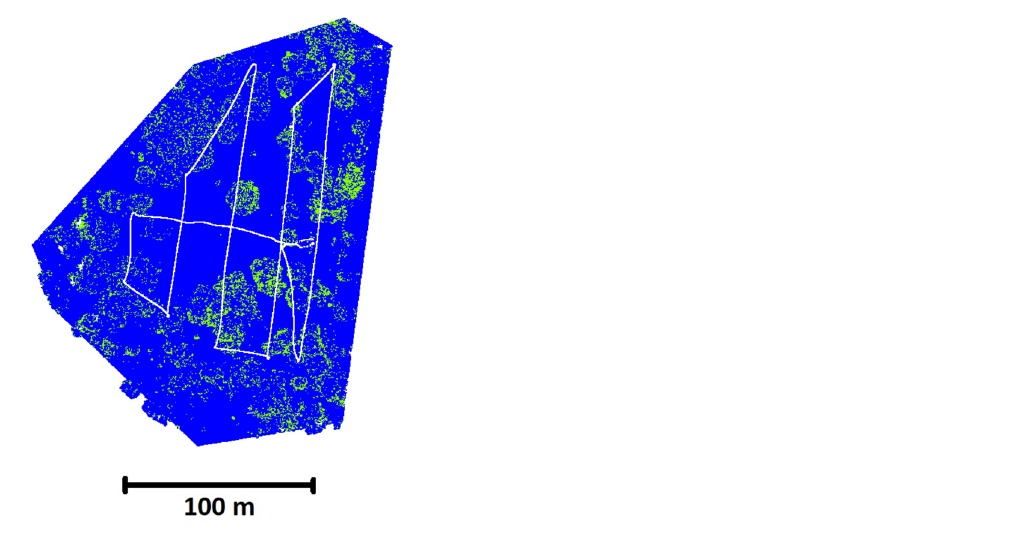
Figure 4. The LiDAR point cloud with the number of returns (blue for one return and green for two returns) along with the flight line of the UAV for data collection (in white).